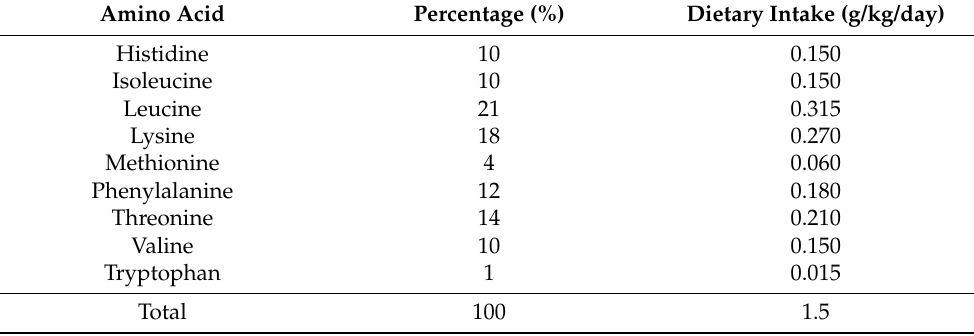
Table 1. Composition and relative intake of